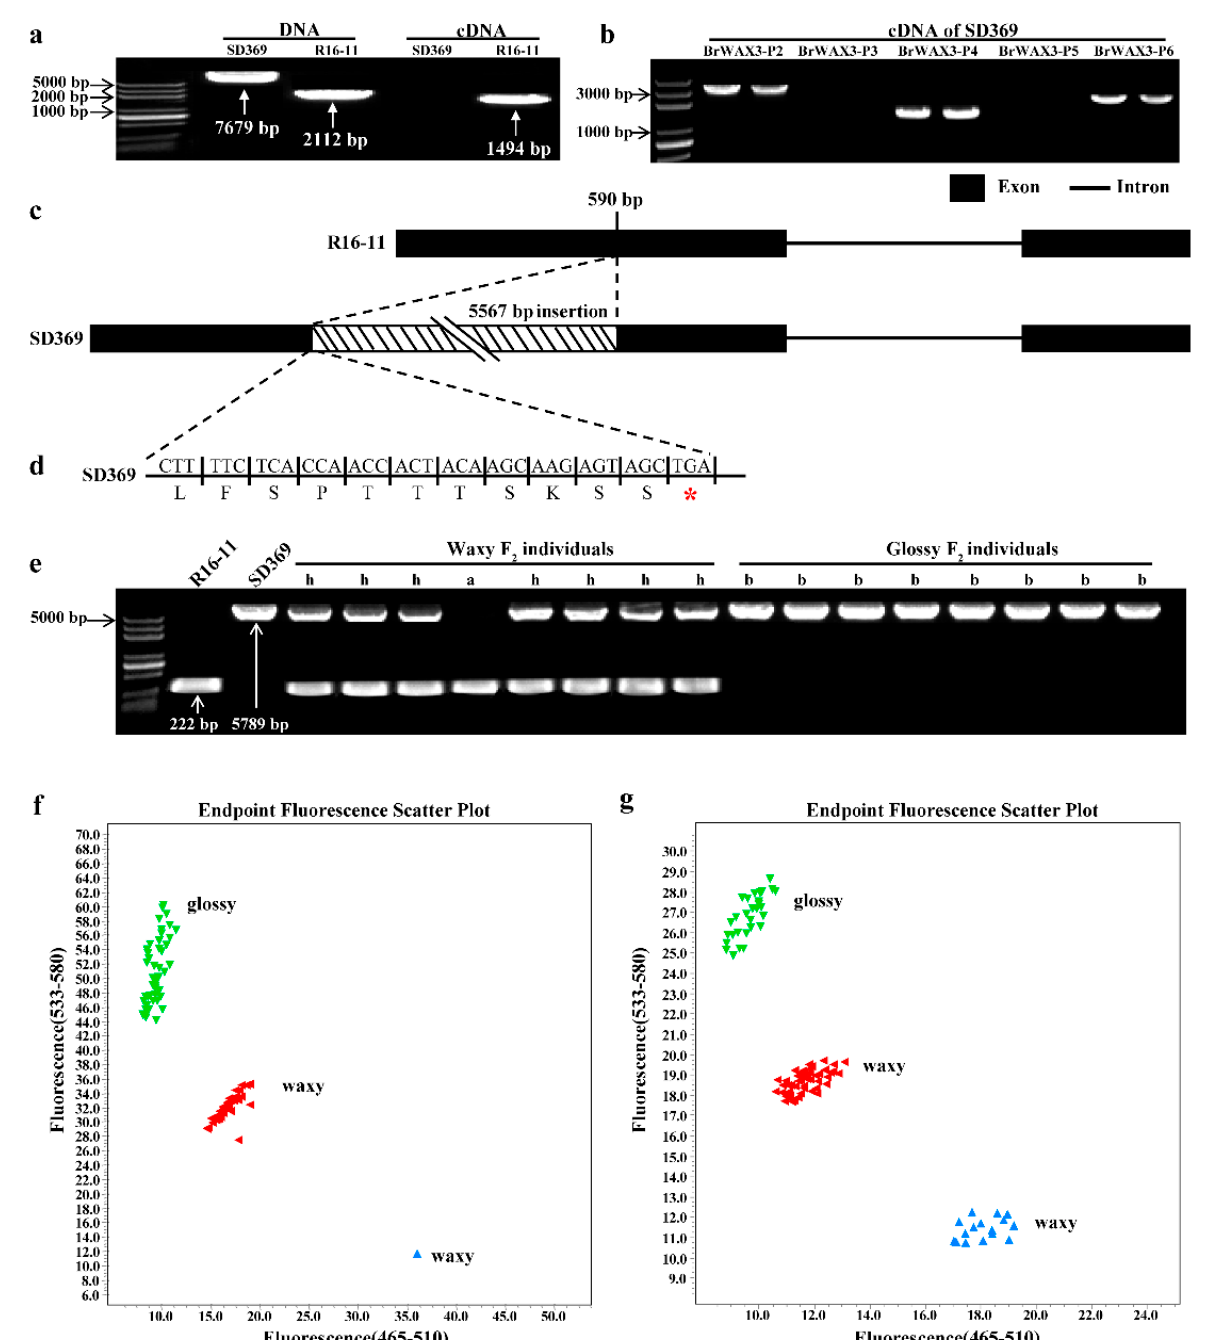
Figure 4. Candidate gene analysis of BrWAX3 . ( a ) Amplification products of the full length primer using DNA and cDNA from SD369 and R16-11. The full length CDS of glossy SD369 could not be detected. ( b ) Amplification products of each fragmental primer using cDNA from SD369. ( c ) BrWAX3 includes 2 exons and 1 intron. ( d ) A 5567-bp insertion in glossy SD369 caused a premature stop codon. ( e ) Validation of the functional marker BrWAX3-InDel in F 2 individuals. ( f , g ) Validation of the functional marker BrWAX3-KASP1 in BC 1 P 1 population ( f ) and in (SD369 × SD2135)-F 2 population ( g ). Based on the 5567-bp insertion, a functional marker BrWAX3-InDel (primer pairs BrWAX3-InDel-F and BrWAX3-InDel-R, Table S5), which could amplify a 222-bp and 5789- bp product from lines R16-11 and SD369, respectively, was developed. When Phanta ® Table 2. Annotated genes in the candidate interval of the BrWAX3 locus. High-Fidelity DNA Polymerase (5 s/kb amplification rate) (Vazyme, Nanjing, China)